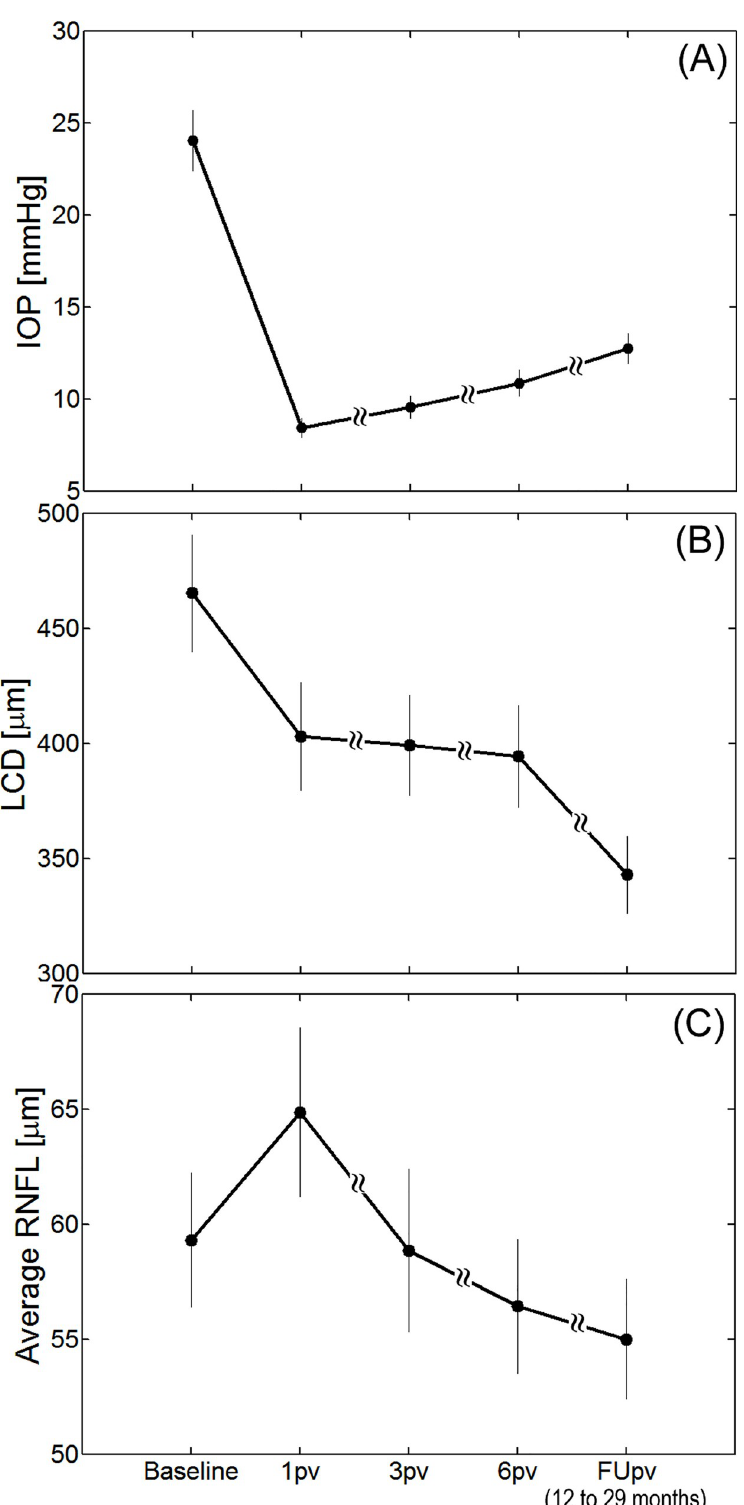
Fig 3. The time course of the intraocular pressure (IOP) (A), lamina cribrosa depth (LCD) (B) and average RNFL thickness (C) at each control visit with respect to the baseline values. The error bars denote one standard error. Note that the points on the abscissa are not